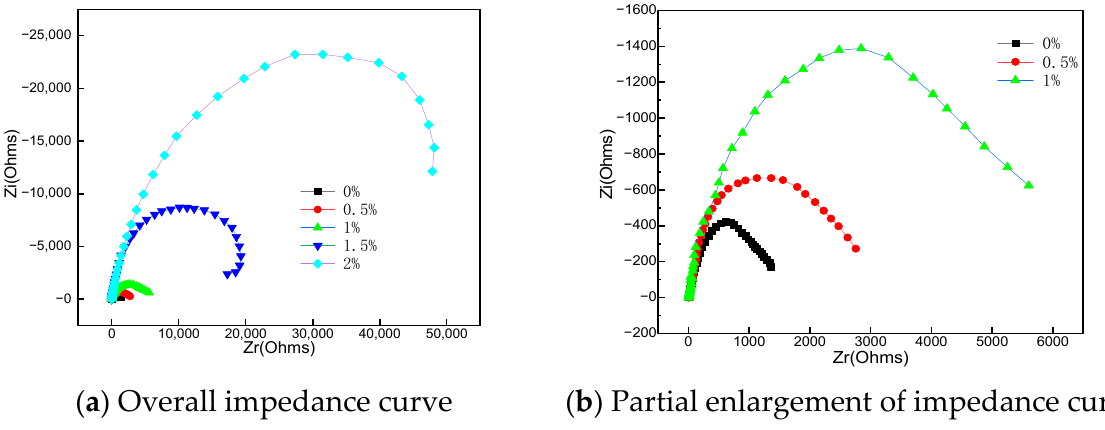
In order to study the effect of boron addition on the passivation characteristics of surfacing layer in 3.5% NaCl solution, AC impedance test was further carried out on the sample, and the results are shown in Figure 7.